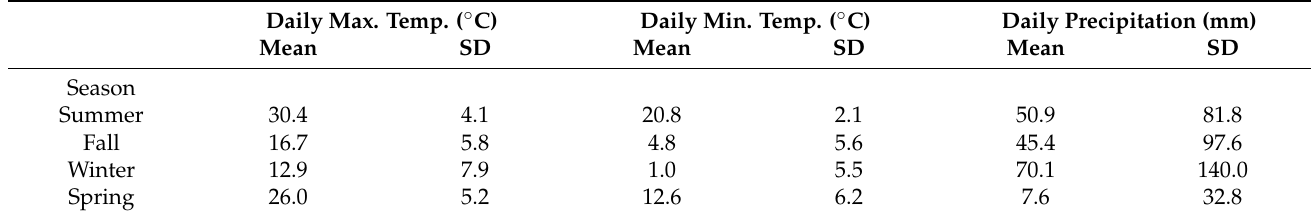
Table 3. Mean and standard deviations of daily maximum and minimum temperatures and daily precipitation for each season of sampling period.